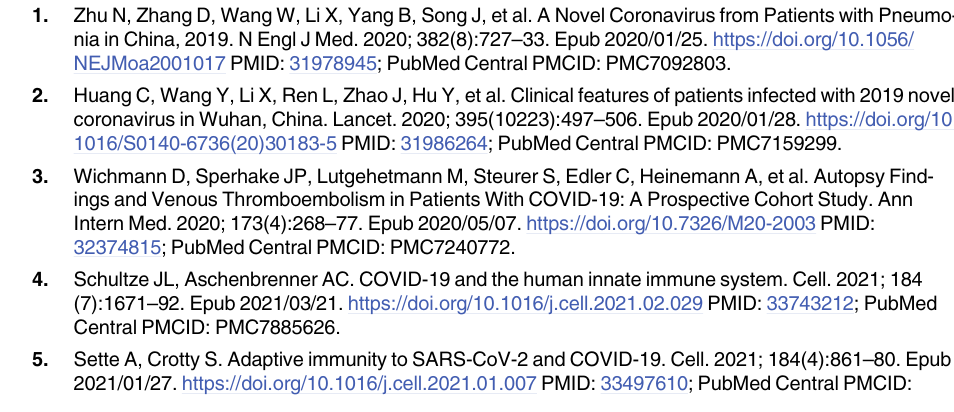
S5 Table. Flow cytometry data used for